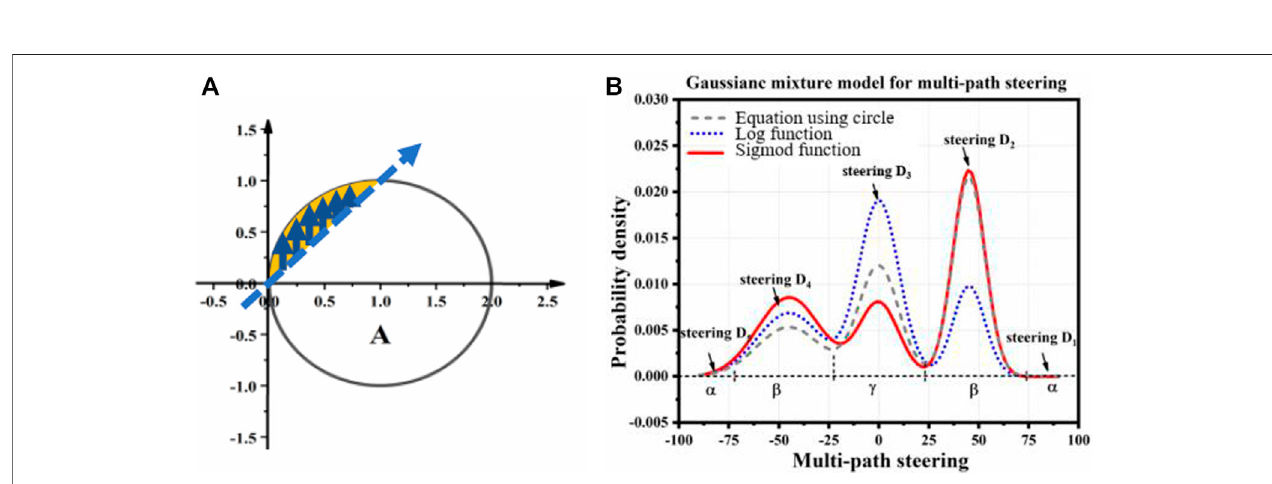
FIGURE 25 | Squeeze the arrival rate of obstacles to get the rejection rate. (A) Squeeze the equation of a circle (B) Squeeze the steering distribution.